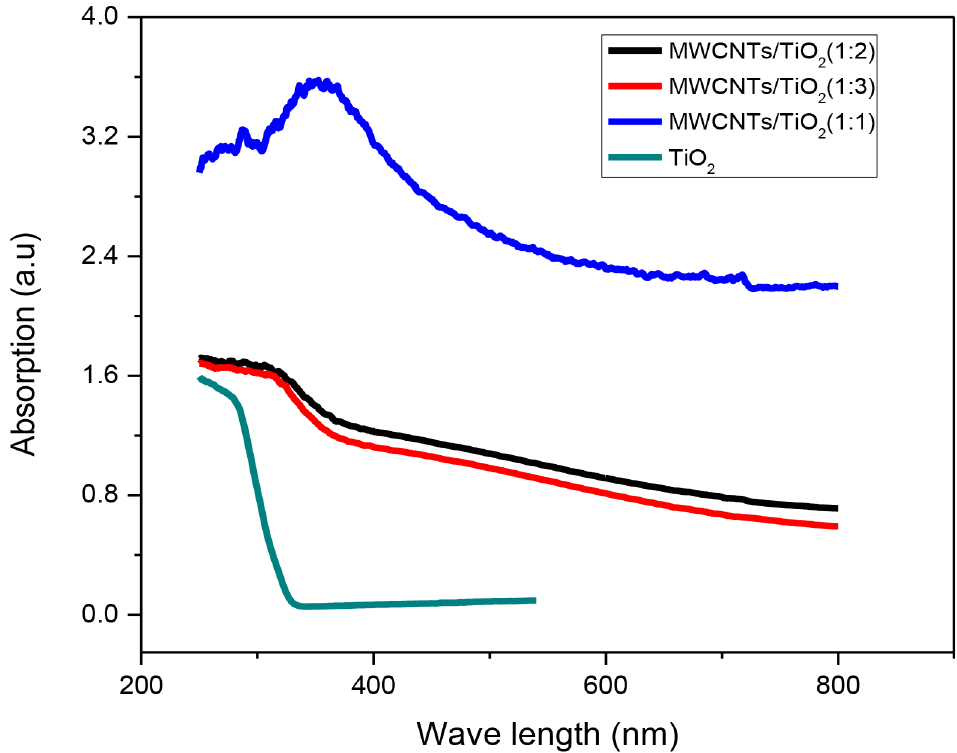
Fig 4. UV-vis diffuse reflectance spectra of the MWCNTs/TiO 2 nanocomposites of different weight ratios and TiO 2 -